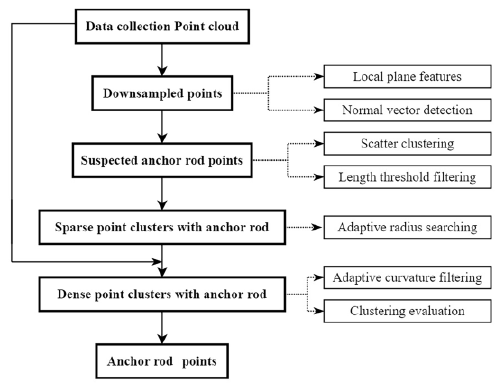
Figure 1. General